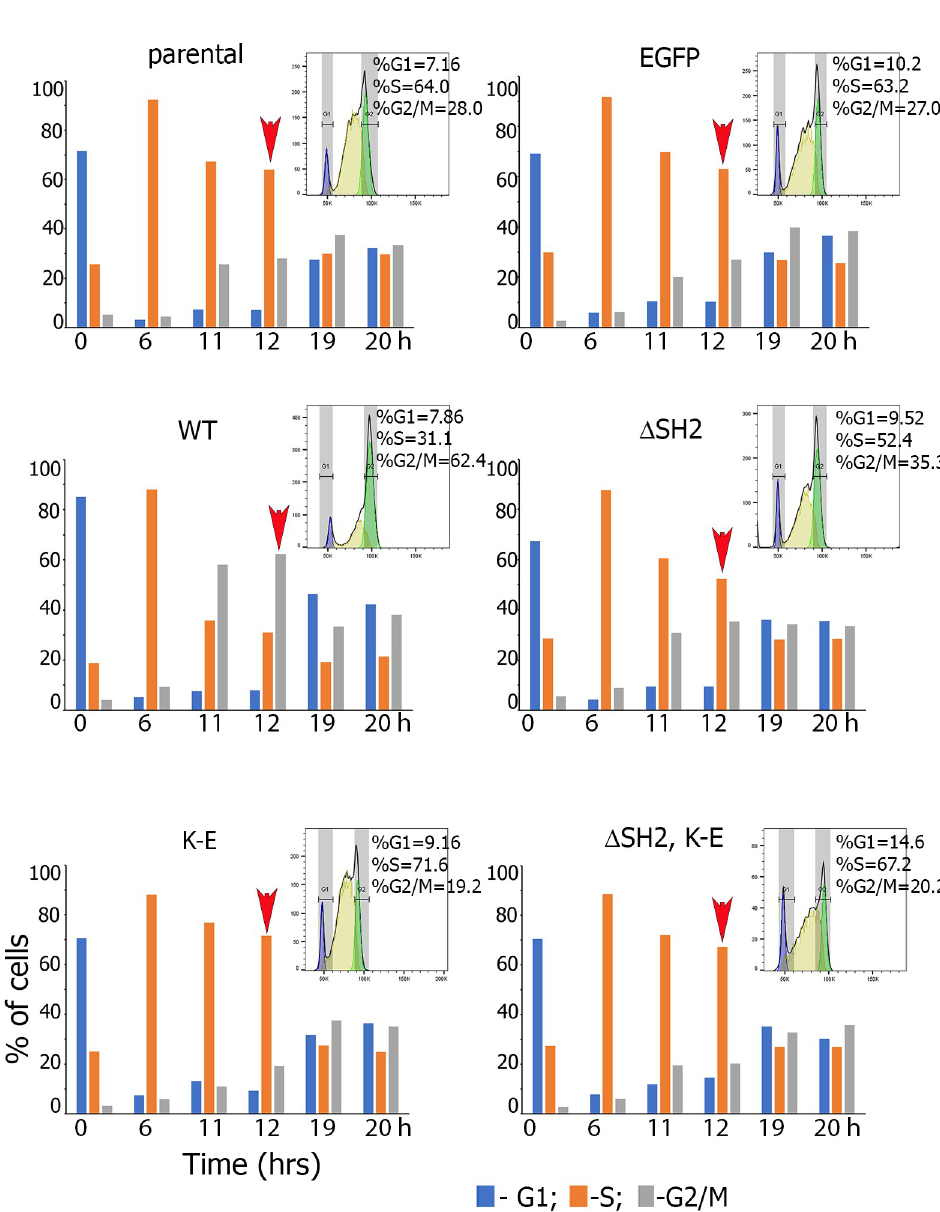
Fig 6. Cell cycle analysis of MCF-7 cell clones. Parental MCF-7 cells and the MCF-7 cell clones stably overexpressing indicated constructs were PRL-treated and synchronized at the G1/S boundary by single thymidine block. To determine the duration of S and G2/M phases, the cells were released, collected every 2 hrs and analyzed by FACS. In 12 hrs after the release only majority of JAK2 WT cells were in G2/M phase while parental, EGFP and mutant cells still stayed in S phase (arrowhead). The FACS analysis was repeated three times for each experimental condition with similar results. Figure demonstrates the representative experiment.